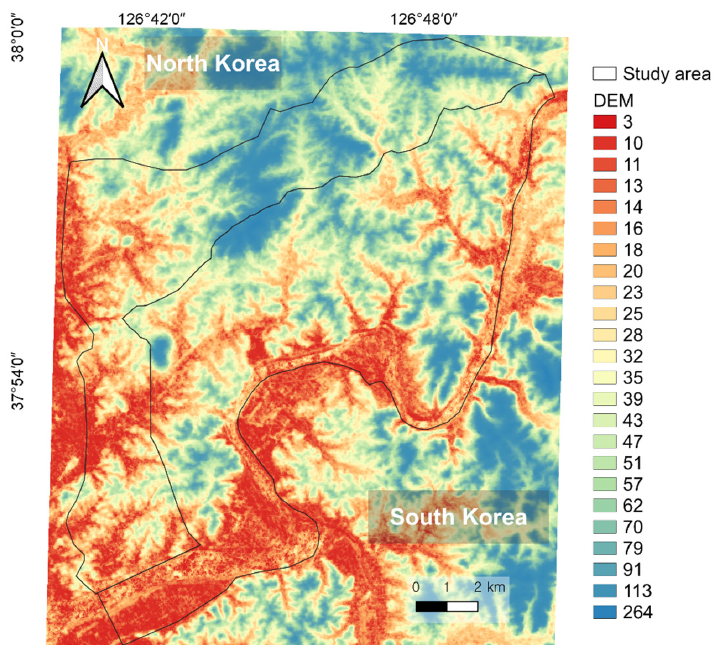
Figure A1. Digital elevation model (DEM) of the study site. ASTER GDEM was used, which was downloaded from USGS (https://earthexplorer.usgs.gov/, accessed on 1 June 2021).